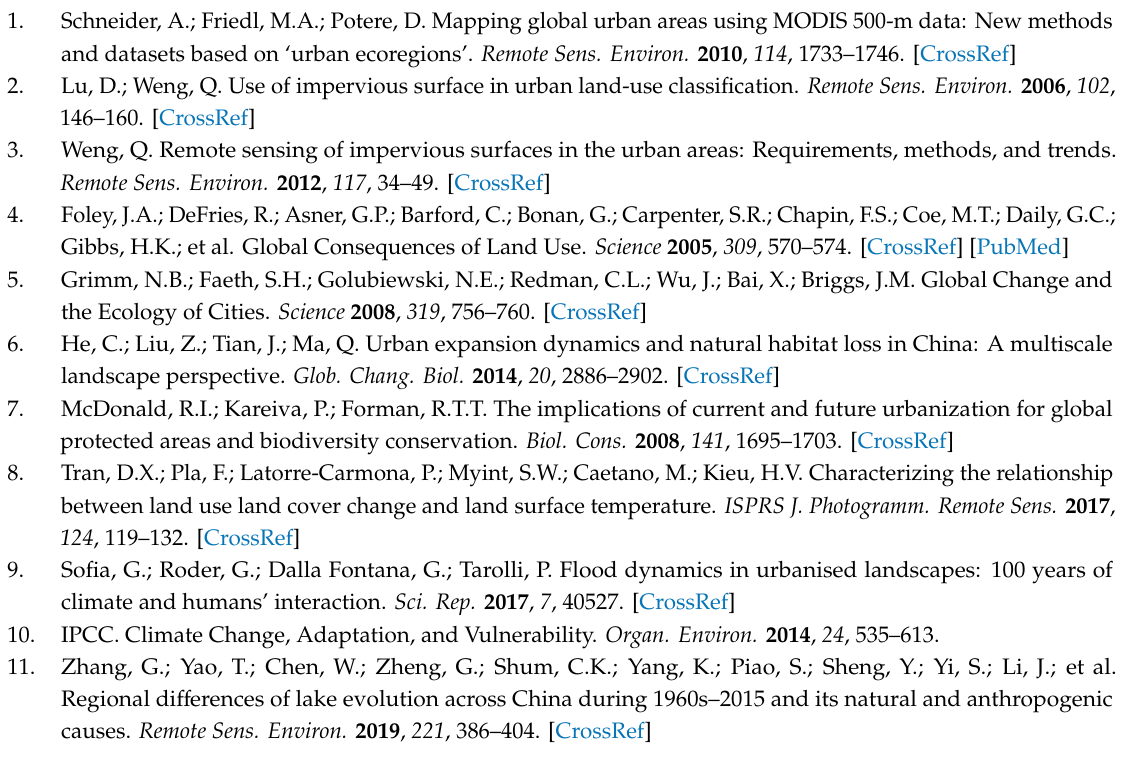
Figure S1: VIIRS nighttime lights categorized using the Jenks natural breaks algorithm in an example area (Study Area 1, Paris). Figures S2–S5: Built-up area scatter plots. The scatterplots compare the percentages of built-up areas using validation data in 9 km 2 grids against those of (a) our method, (b) FROM-GLC, (c) GUL, (d) PII in Study Area 1 (Paris), Study Area 2 (Ankara), Study Area 3 (Madrid), Study Area 4 (Lisbon), respectively. Table S1: Percentages of pixels with DN = 0 and DN > high threshold in the four study areas. Author Contributions: C.L., K.Y., and M.L. designed the study. C.L. performed the data analysis. C.L. and K.Y. wrote the paper with contributions from all